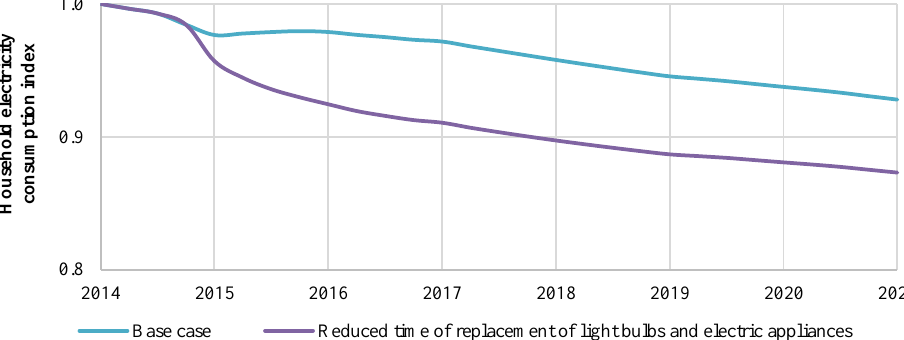
equipment have higher efficiency. This is demonstrated by the calculated results (Fig. 9), when time of replacement of the equipment is set to nearly zero value.